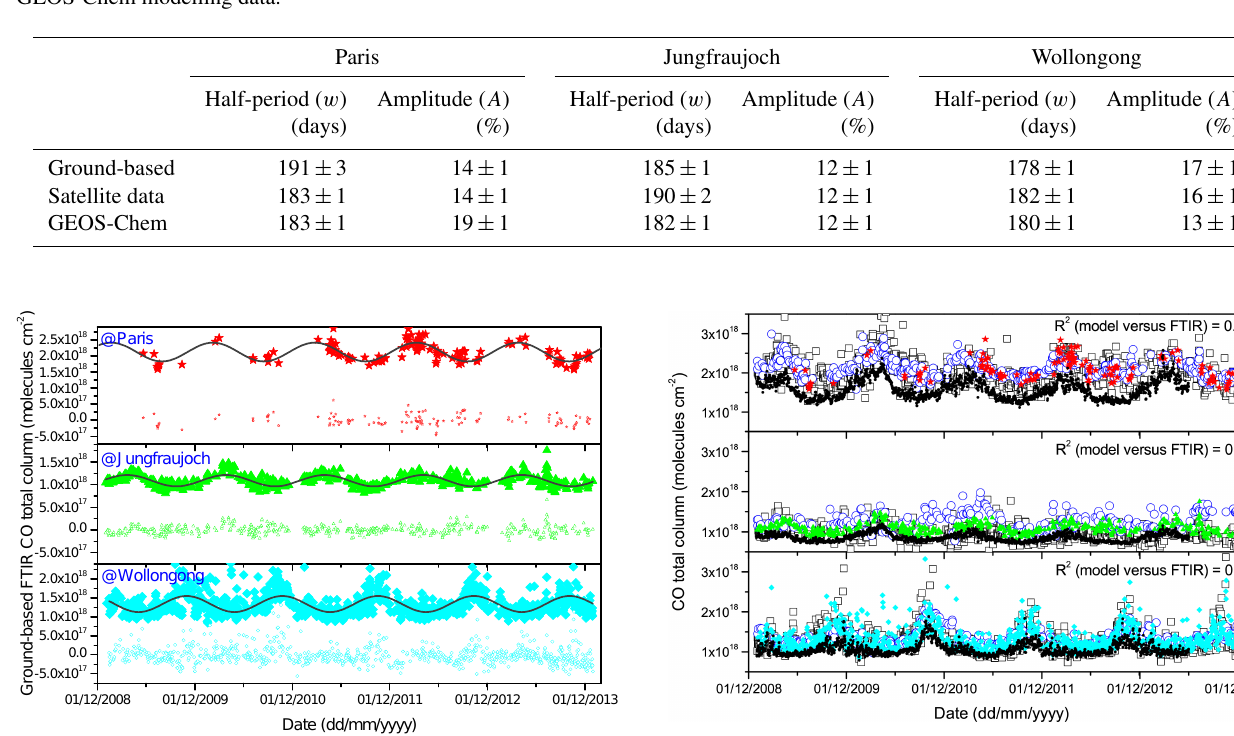
Table 2. Parameters obtained from the sinusoidal fit of the seasonal variability to the CO total columns from ground-based, satellite and GEOS-Chem modelling data.